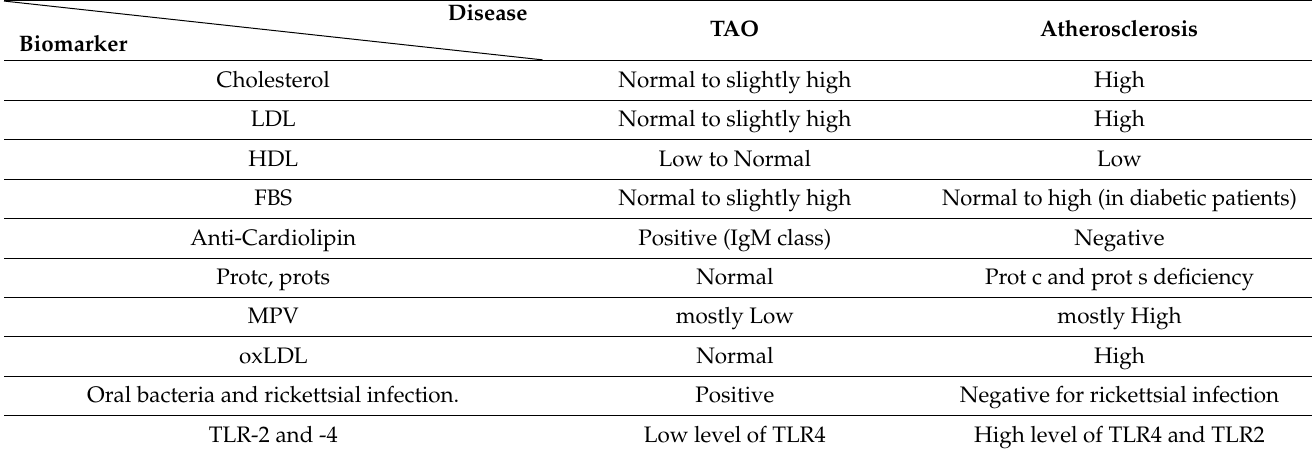
Table 7. Routine laboratory differential diagnostic tests for TAO and Atherosclerosis. Disease Biomarker